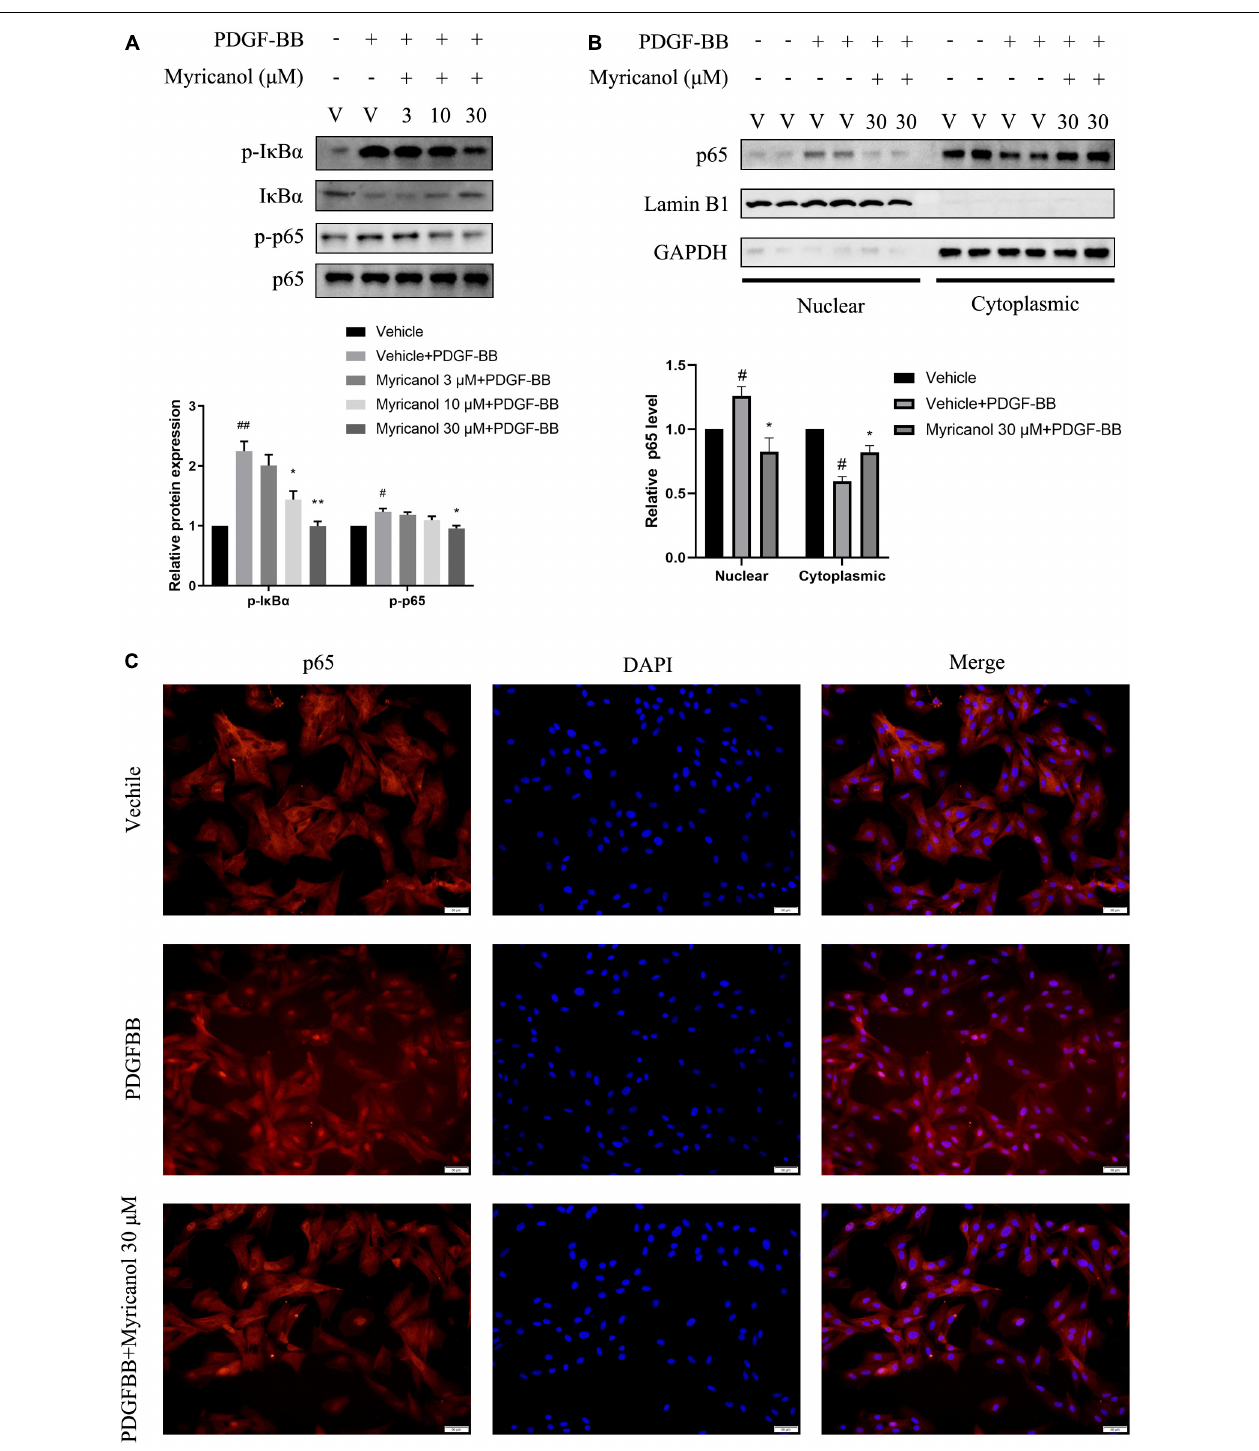
FIGURE 4 | Effects of myricanol on PDGF-BB-induced NF- κ B signaling in VSMCs. (A) After being pretreated with indicated concentrations of myricanol or vehicle for 30 min, the cells were stimulated by PDGF-BB (30 ng/ml) for 5 min. The protein level of p-I κ B α , I κ B α were determined by Western blot analysis. After being pretreated with indicated concentrations of myricanol or vehicle for 30 min, the cells were stimulated by PDGF-BB (30 ng/ml) for 30 min. The protein level of p-p65 and p65 were determined by Western blot analysis. (B) p65 nuclear translocation was analyzed by Western blot analysis. (C) p65 nuclear translocation was analyzed by immunocytochemistry. Scale bar, 50 µ m. Data are represented as mean ± SEM ( n = 3). # P < 0.05, ## p < 0.01 vs. the Vehicle group. * P < 0.05, ** p < 0.01 vs. the Vehicle + PDGF-BB group.